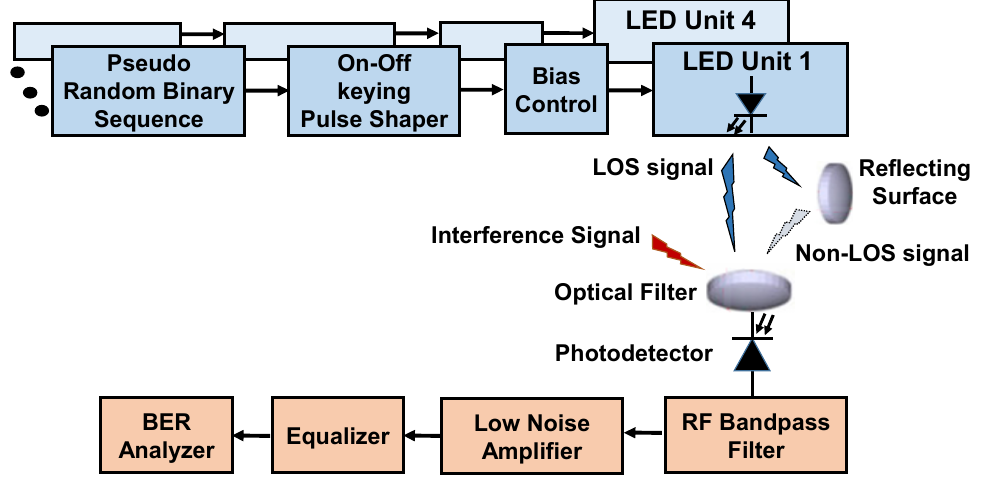
Figure 2. System model consisting of the transmitter, channel and receiver modules to realize the SISO or MISO transmission. or MISO